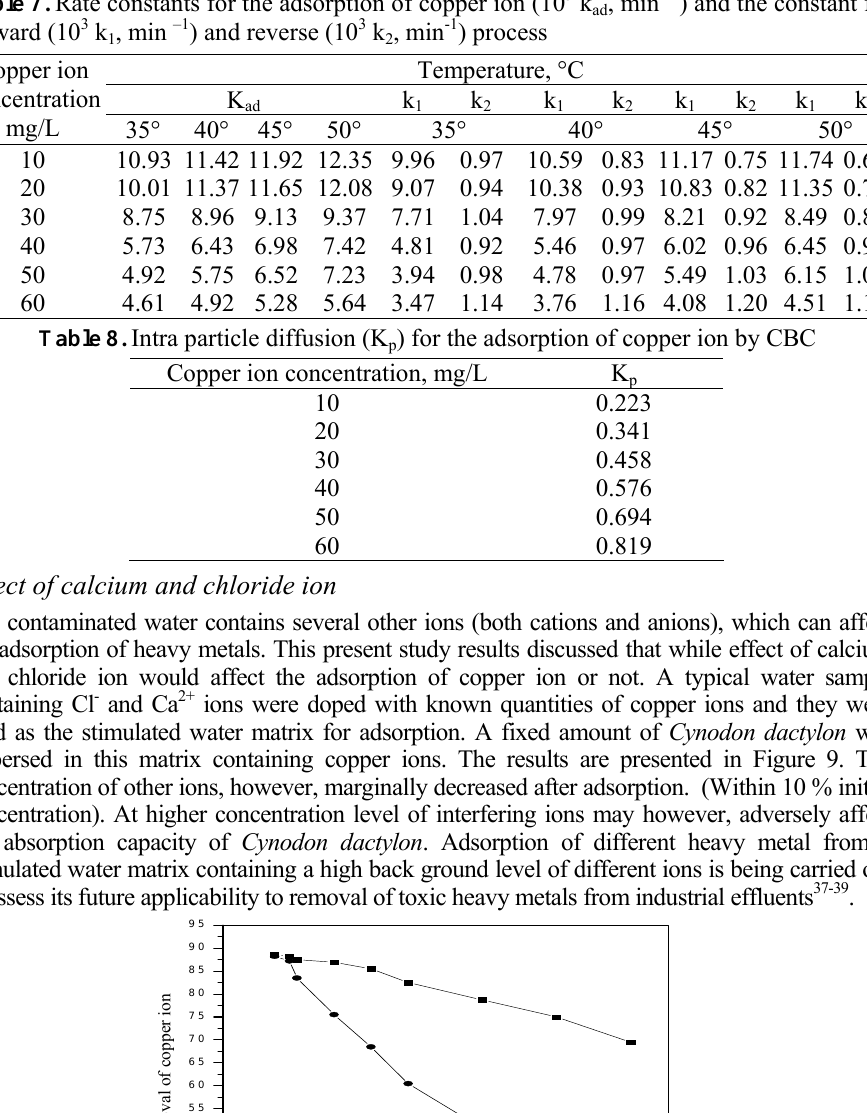
, min -1 ) and the constant for ad